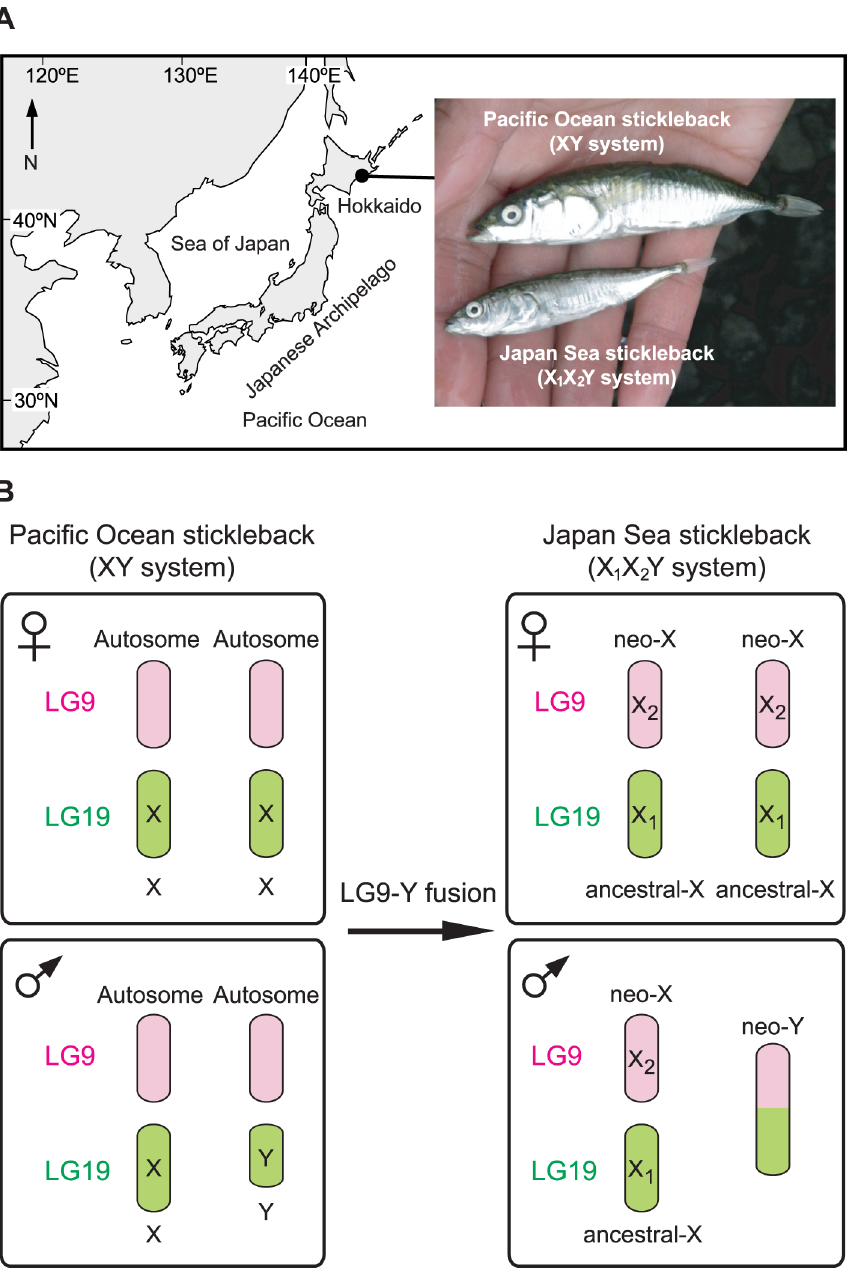
Figure 1. The Japanese sympatric stickleback species pair. (A) Sampling site and representative images of a sympatric Pacific Ocean stickleback and a Japan Sea stickleback caught from a sympatric habitat. The Pacific Ocean and Japan Sea sticklebacks have different sex chromosome systems. (B) A chromosomal fusion between an autosome (LG9 shown in pink) and a Y chromosome (LG19 shown in green) in the Pacific Ocean stickleback created an X 1 X 2 Y sex chromosome system in the Japan Sea